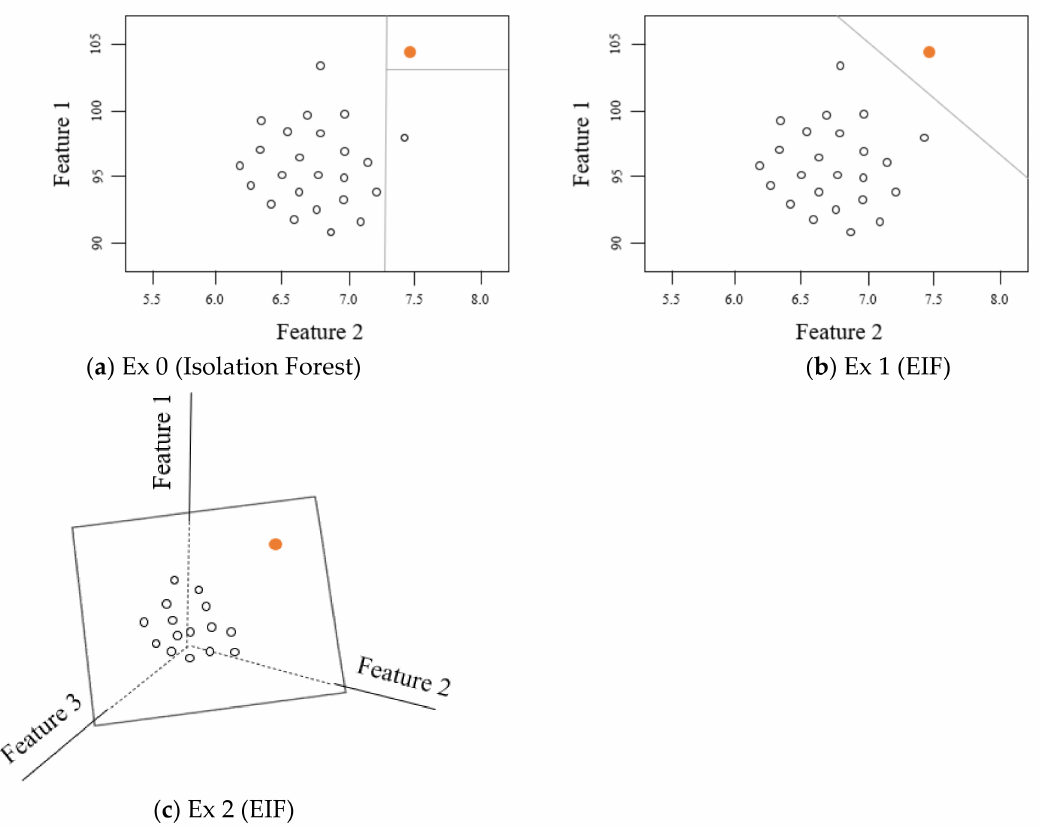
Figure 2. Comparisons of abnormal diagnoses between ( a ) isolation forest and ( b , c ) extended isolation forest